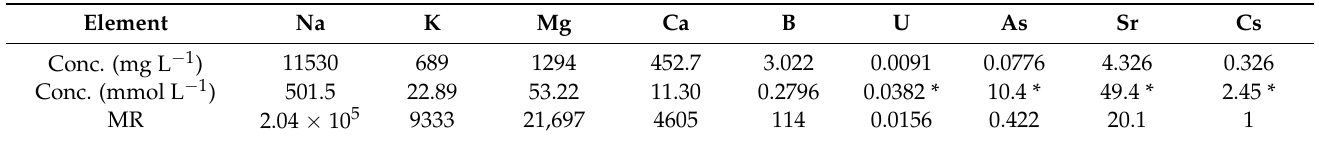
Figure A20. Location of sample collection (Beihai, China). Table A8. Composition of the seawater sample.